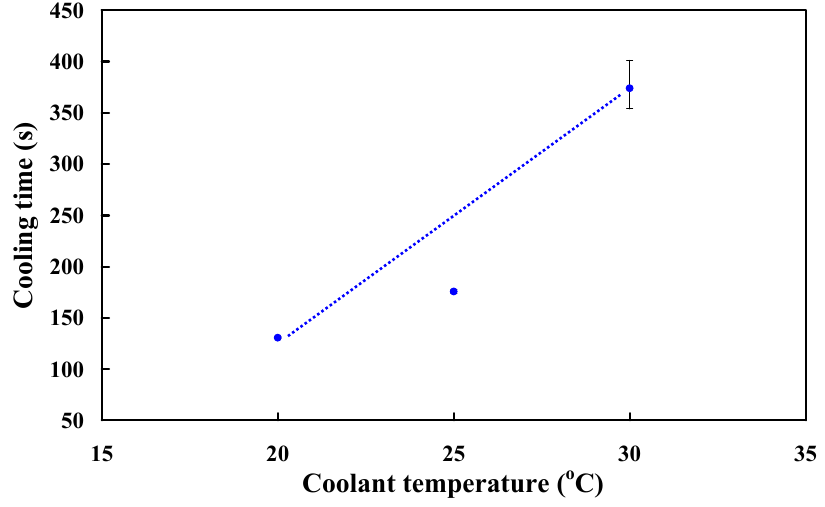
Figure 23. Cooling time of the molded parts as a function of different coolant temperatures.